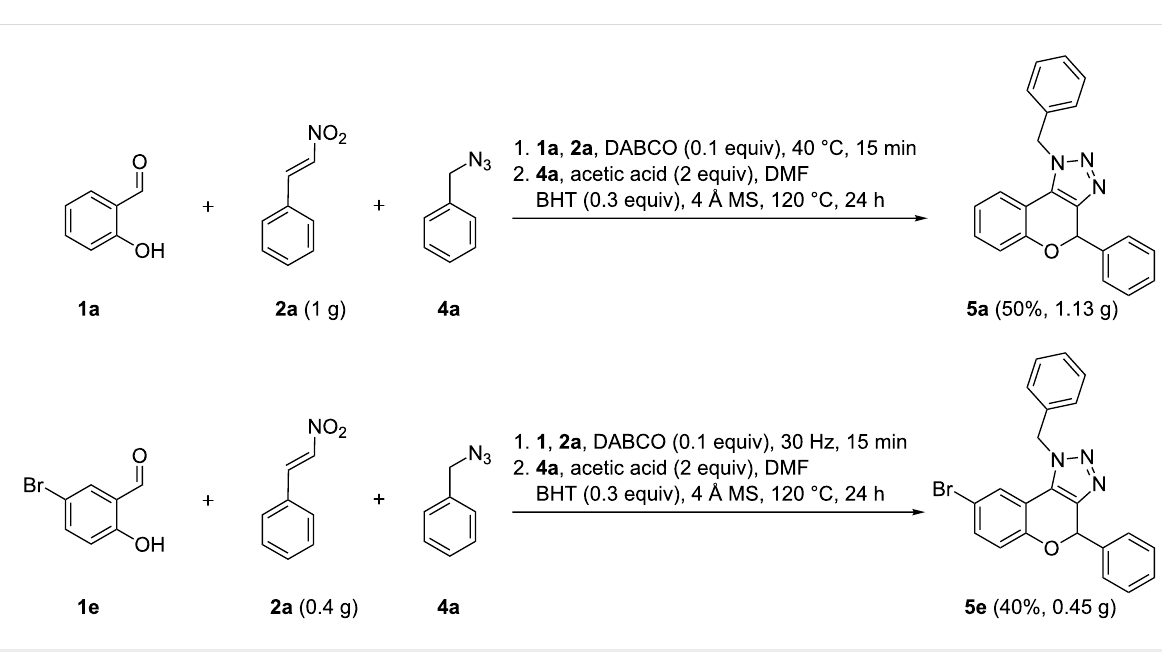
Scheme 4: Scale-up of the one-pot three-component reaction and two-step ball milling